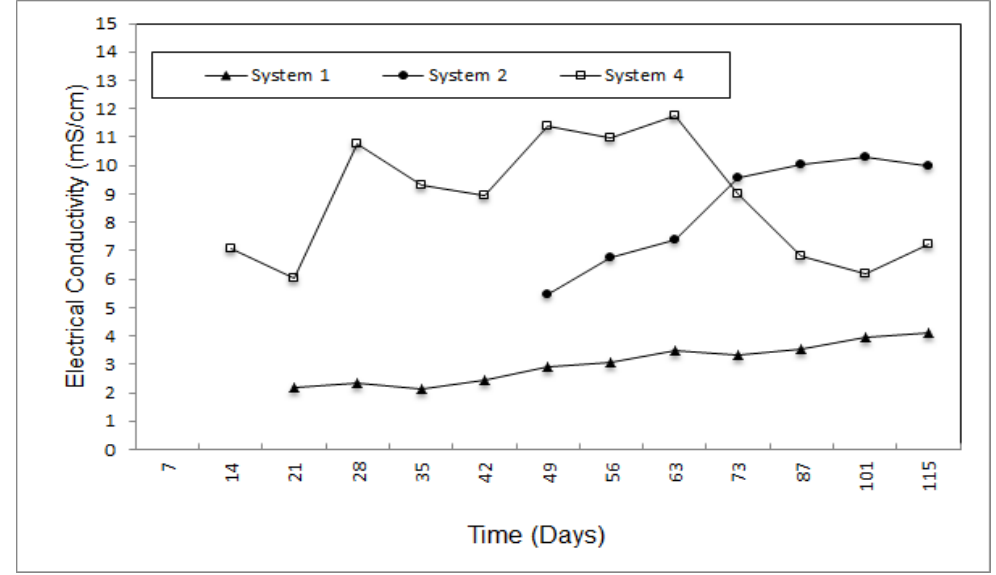
Figure 4. Variation of the leachate electrical conductivity for system 2 and system